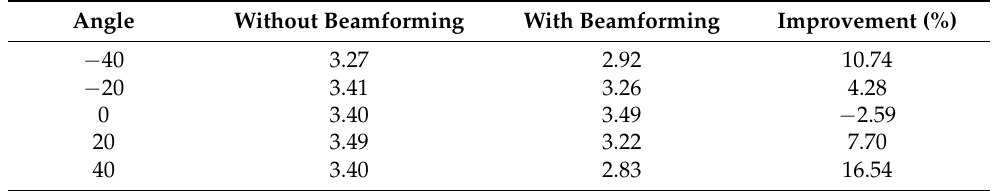
Table 8. The MAE of HR at all three distances (0.9, 1.2 and 1.5 m). Angle